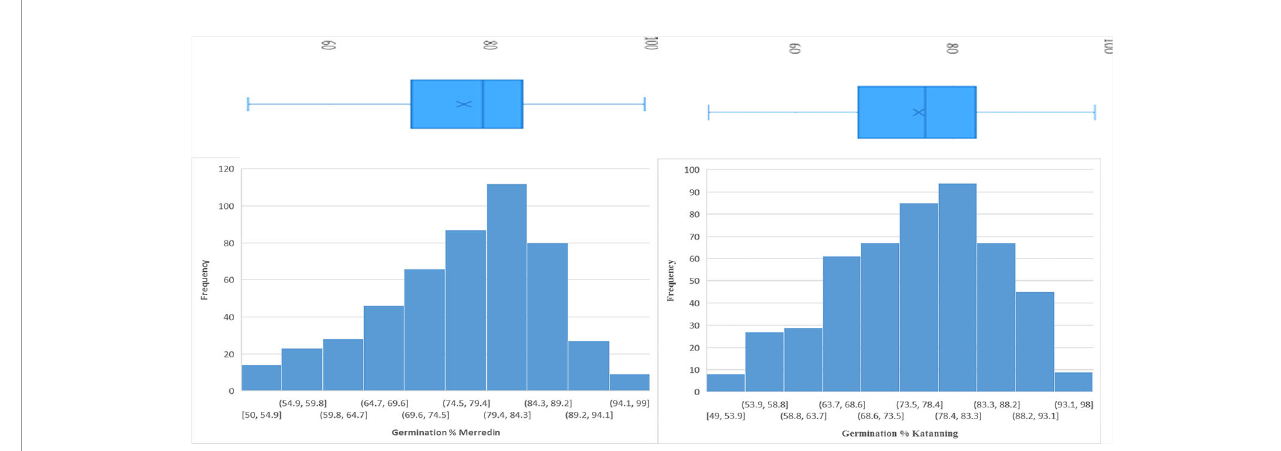
FIGURE 1 | Combined histogram and plot block for germination percentage of 350 barley genotypes under 150 mM NaCl for seeds sourced from Merredin and Katanning,